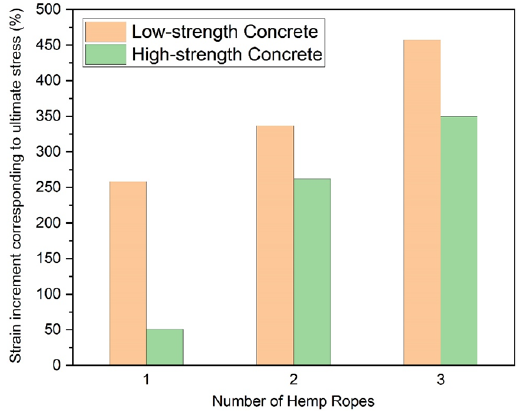
Figure 9. Comparison of increment in ultimate compressive strength due to number of hemp ropes (note: low-strength and high-strength concrete correspond to Type-1 and Type-2 concrete, respectively).